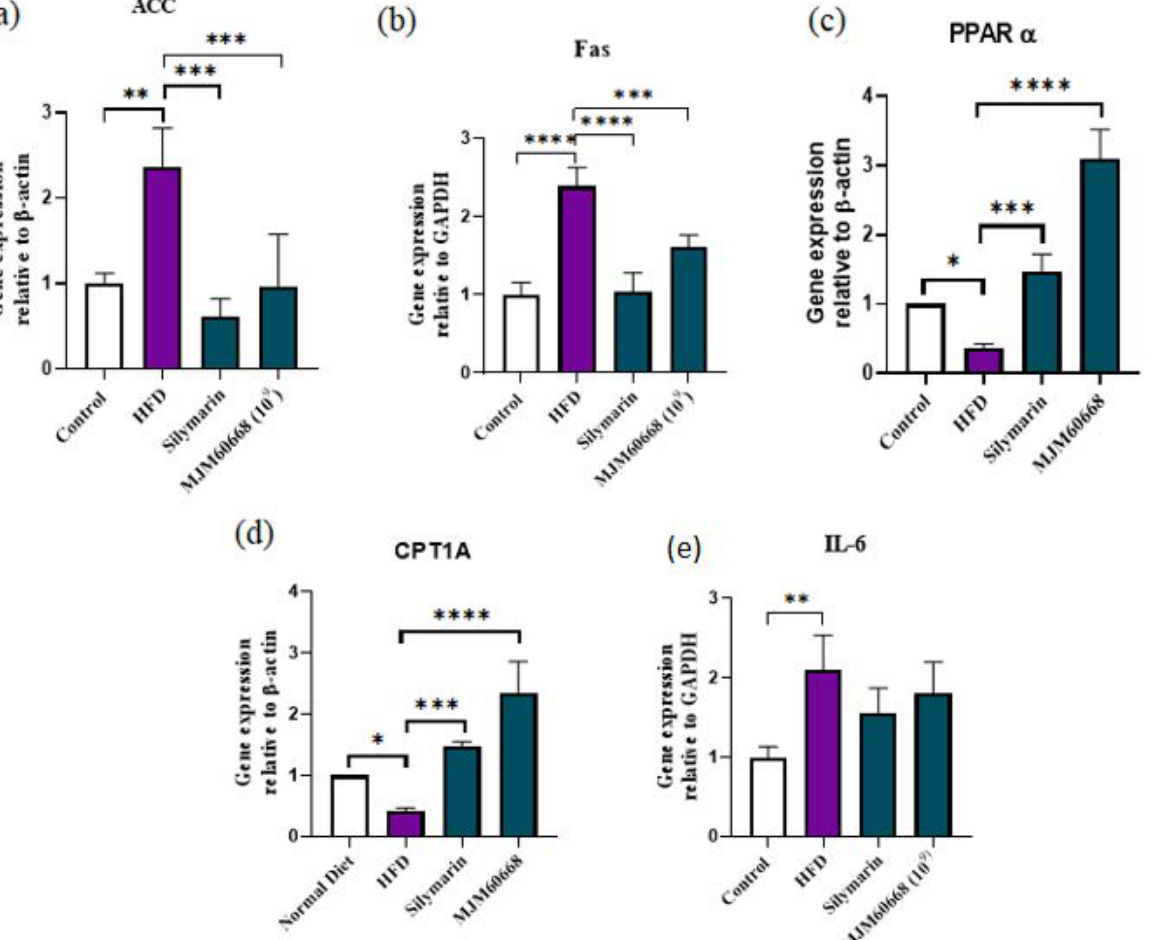
Figure 7. The effect of L. reuteri MJM60668 on mRNA expression in hyperlipidemia mouse ( a ) the mRNA expression of ACC in mice liver, ( b ) mRNA expression of Fas in mice liver, ( c ) mRNA expression of PPAR α in mice liver, ( d ) mRNA expression of CPT1A in mice liver, ( e ) mRNA expression of IL-6 in mice liver. Data represented as mean ± S.E.M of three independent experiments. n =